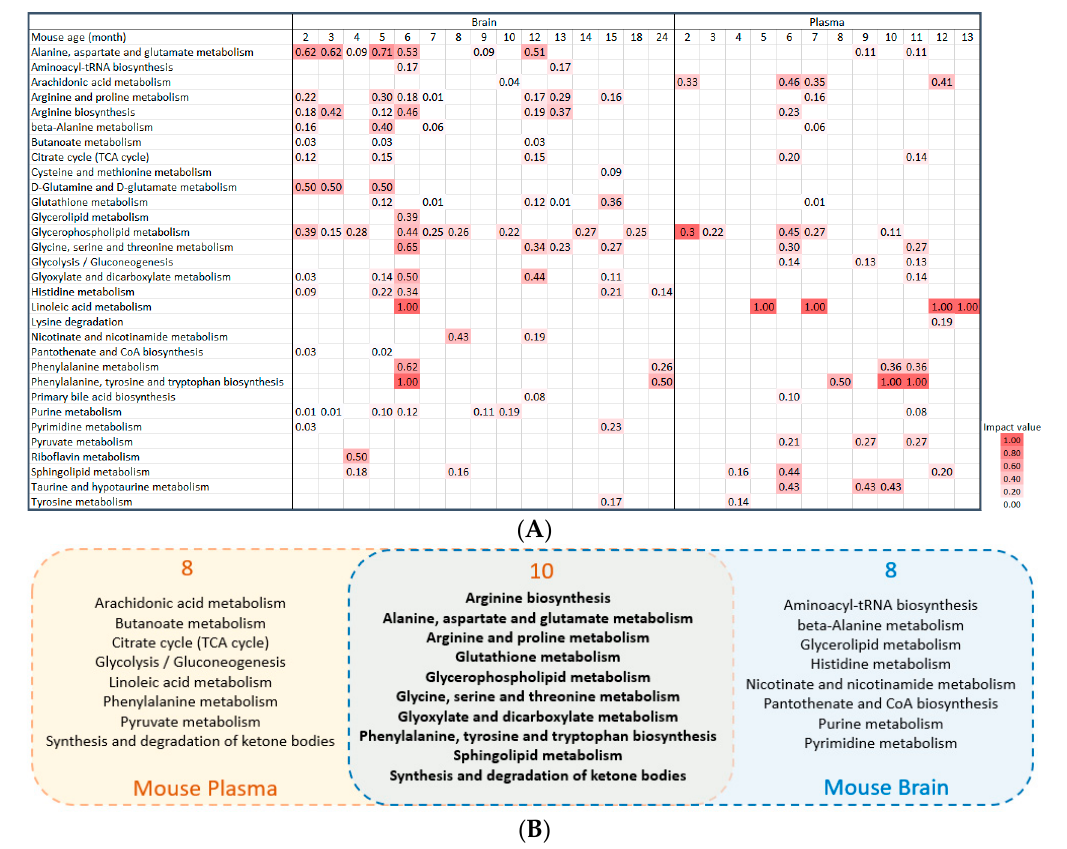
Figure 4. Altered metabolic pathways in mouse plasma and brain samples, comparing AD and control animals. ( A ) Heatmap of the changes of significantly altered metabolic pathways at different ages of AD mouse in brain and plasma samples. The impact value is calculated as the sum of the importance measures of matched metabolites normalized by the sum of the importance measures of all metabolites in each pathway. ( B ) Altered pathways in AD mouse plasma and brain samples combining all age groups. Yellow circles are all the disturbed pathways in mouse plasma samples, blue circles are all the disturbed pathways in mouse brain samples, and the middle intersection is pathways in common among plasma and brain samples in mouse research.